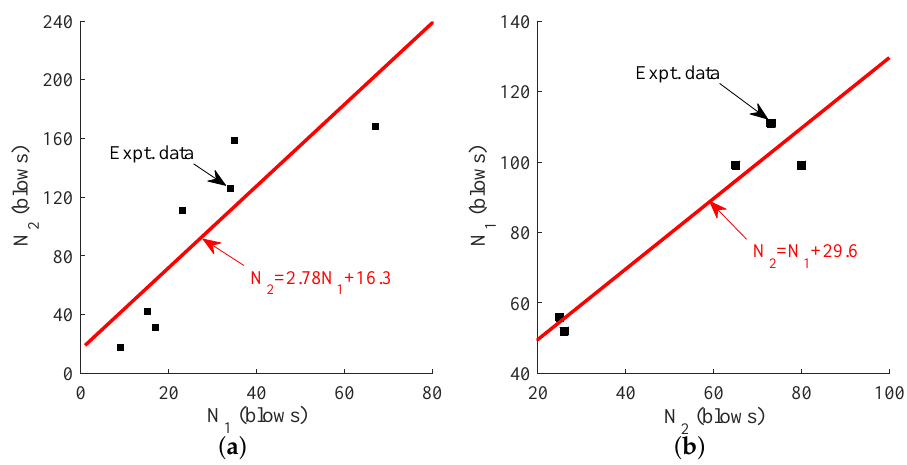
Figure 12. Best fit for first crack and failure strength. ( a ) Steel-PP HFRC impact test results fit; ( b ) Steel-PVA HFRC impact test results